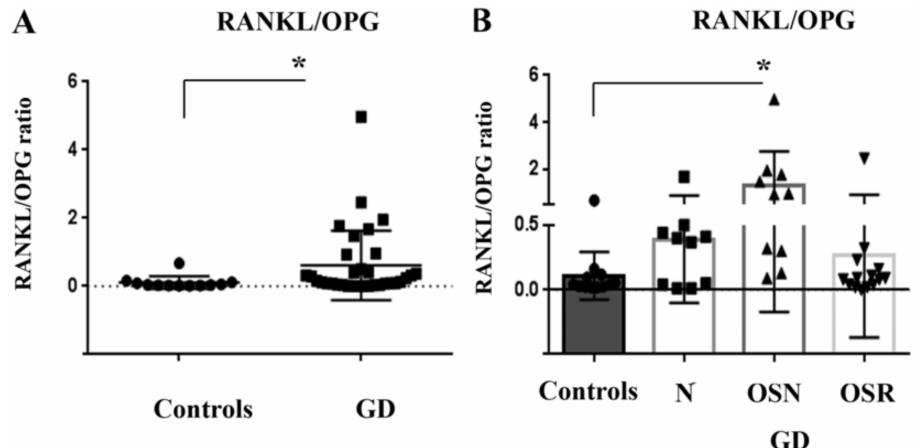
Figure 5. RANKL/OPG ratio. ( A ) Comparing RANKL/OPG ratio in control (mean 0.10 ± 0.06, n = 10) vs. GD cohorts (mean 0.60 ± 0.17, n = 33). F test significant p < 0.05 ( B ) RANKL/OPG ratio in control group (mean 0.11 ± 0.08, n = 10); GD-N (mean 0.39 ± 0.17, n = 9); GD-OSN (mean 1.3 ± 0.46, n = 10); and GD-OSR (mean 0.27 ± 0.170, n = 14) groups. Data are means ± SEM. ANOVA test, Bartlett’s multiple-comparisons, and Kruskal–Wallis tests (* p < 0.05) showed significant differences between groups. Tukey’s multiple-comparison test demonstrated significant differences between control vs. OSN